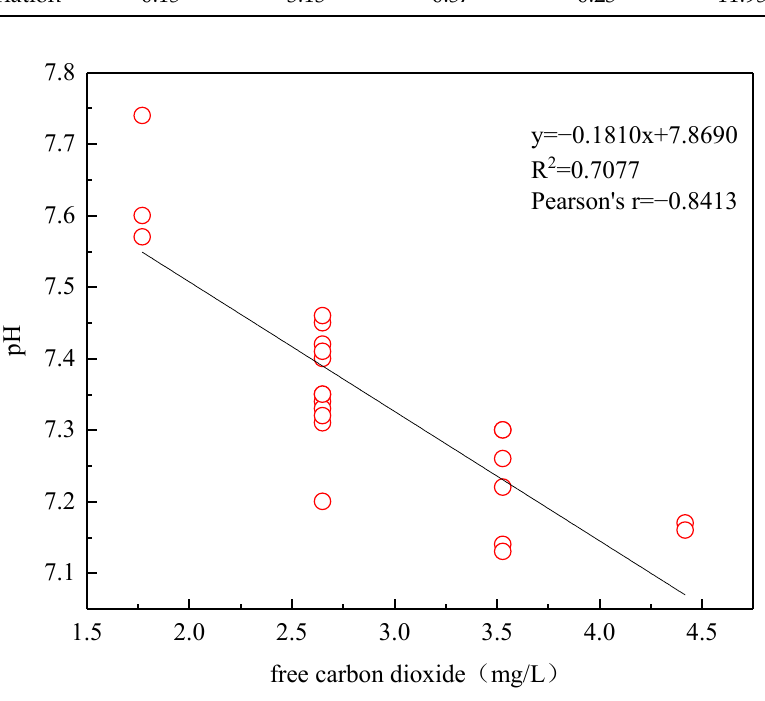
Figure 2. Linear fitting of free carbon dioxide and pH.